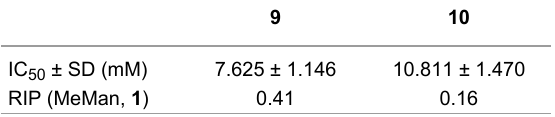
Table 2: Inhibition of bacterial adhesion ( E. coli ) to a mannan-coated surface. The inhibitory potencies of Amadori rearrangement products are compared to the standard inhibitor MeMan ( 1 ). a 9 10 IC 50 ± SD (mM) 7.625 ± 1.146 10.811 ± 1.470 RIP (MeMan, 1 ) 0.41